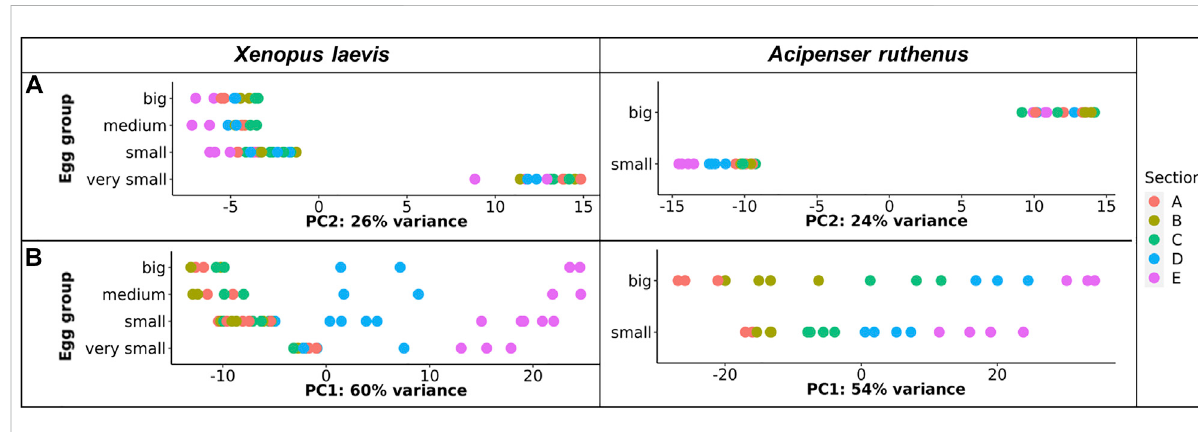
FIGURE 3 PCA plot showing the top 500 most variable genes for each of the different oocyte sizes from the models. (A) Principle component 2 showing variation in transcript as a function of oocyte size. (B) Principle component 1 showing variation in transcript across segment and size. The sections correspond to the regions of the oocyte that were cryosectioned, whereby sections A - extremely animal, B - animal, C - central, D - vegetal, E - extremely vegetal.